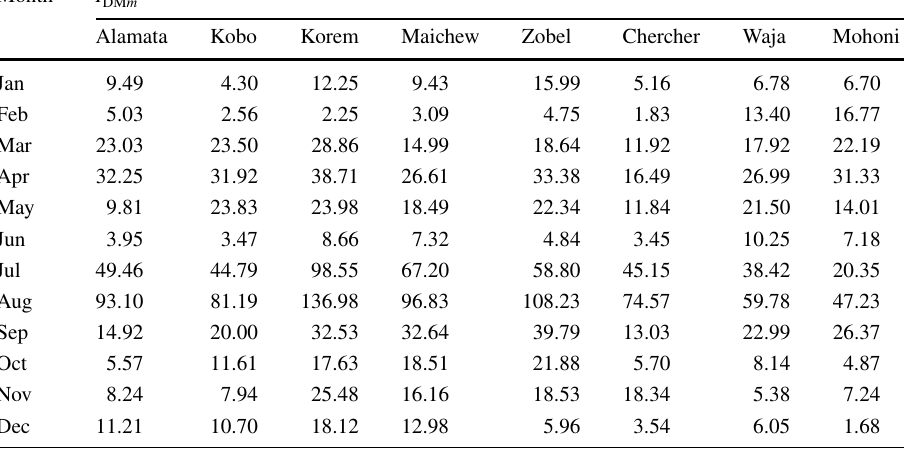
aridity index value at each